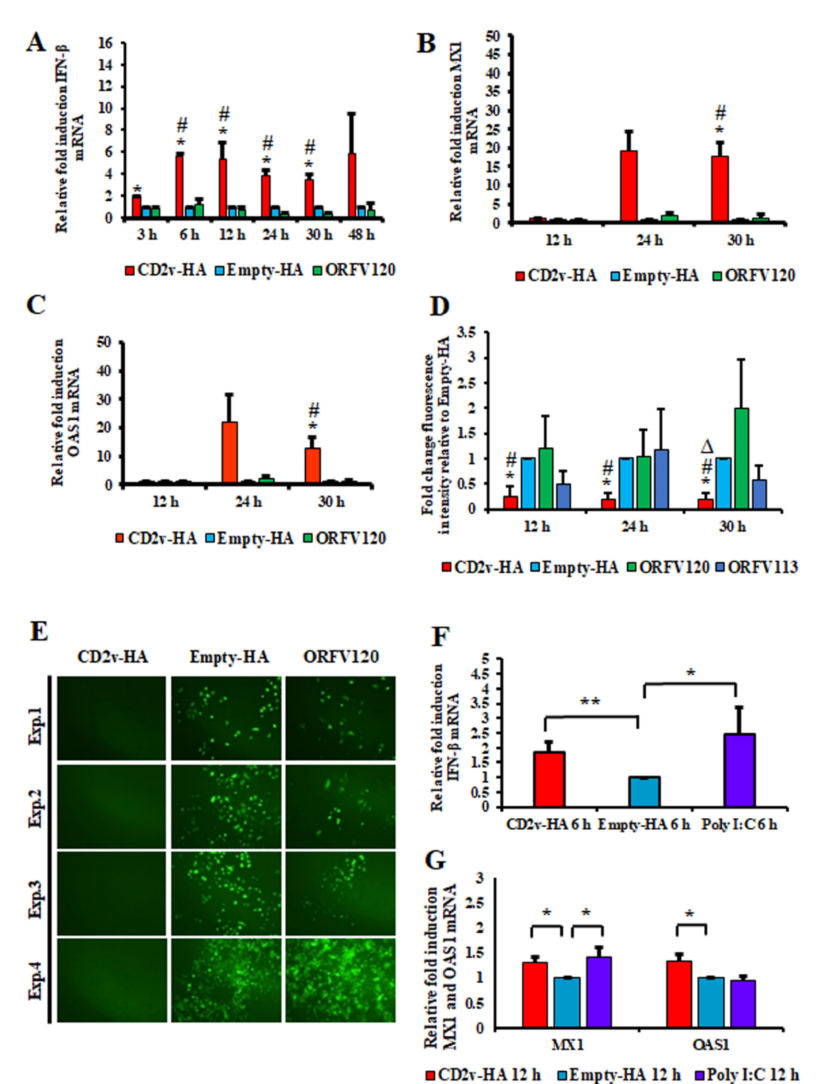
Figure 2. Induction of IFN- β , ISGs and the antiviral state in CD2v-expressing cells. PK15 cells were transfected with plasmids pCD2v-HA or controls pEmpty-HA and pORFV120-Flag (an unrelated viral transmembrane protein control) and transcription of IFN- β and selected ISGs was assessed by real-time PCR. ( A ) Shown are fold changes of IFN- β levels in cells transfected with pCD2v-HA relative to pEmpty-HA and pORFV120-Flag at various times pt. Results are the average mRNA levels from three independent experiments with p -values relative to controls < 0.05 at 3–30 h times pt. ( B , C ) Shown are fold changes of ISG mRNA levels at 12 h, 24 h and 30 h pt. Results are the average mRNA levels from three independent experiments. p -values relative to Empty-HA and ORFV120 at 30 h pt were 0.02 and 0.018 for MX1 ( B ) and 0.04 and 0.037 for OAS1 ( C ). * and # denote statistical significance compared to Empty-HA and ORFV120, respectively. ( D , E ) PK15 cells were transfected with pCD2v-HA, pEmpty-HA or control plasmids (pORFV120-Flag or pORFV113-Flag). At 12 h, 24 h or 30 h pt, cultures were infected with vesicular stomatitis virus expressing GFP (VSV GFP , 50 PFU/well). ( D ) Mean GFP fluorescence measured by flow cytometry at 16 h post infection. Results are the mean values of four independent experiments. p -values relative to transfection with control plasmids were < 0.05 at all times examined. *, # and ∆ denote statistical significance compared to Empty-HA, ORFV120 and ORFV113, respectively. ( E ) Fluorescence microscopy images taken at 16 h post infection with VSV GFP . Note decreased VSV replication in cells transfected with pCD2v-HA relative to controls. Results are representative of four independent experiments. Exp. denotes the experimental replicates. ( F ) Fold changes of IFN- β levels in swine macrophages transfected with pCD2v-HA relative to pEmpty-HA at 6 h pt. Results are the average from five independent experiments. p -value relative to Empty-HA was 0.008 for CD2v-HA. ( G ) Fold changes of ISG mRNA levels at 12 h pt. Results are the average from four independent experiments. p -values for CD2v-HA relative to Empty-HA were 0.014 for MX1 and 0.03 for OAS1, respectively (*, p < 0.05; **, p <